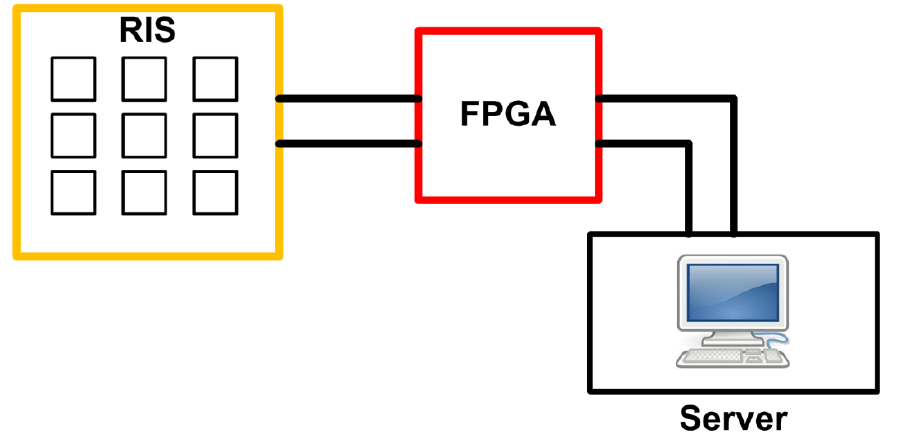
Figure 6. FPGA based dynamically controlled RIS structure.